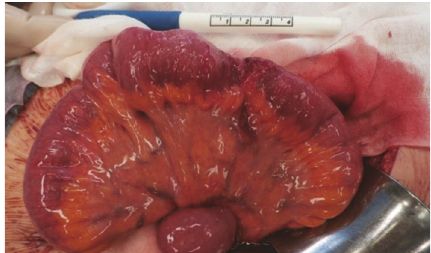
Figure 3: Redness and cicatrization of the small intestine and the mesenterium were observed 20cm cephalad from the terminal ileum, which was thought to be the starting point of